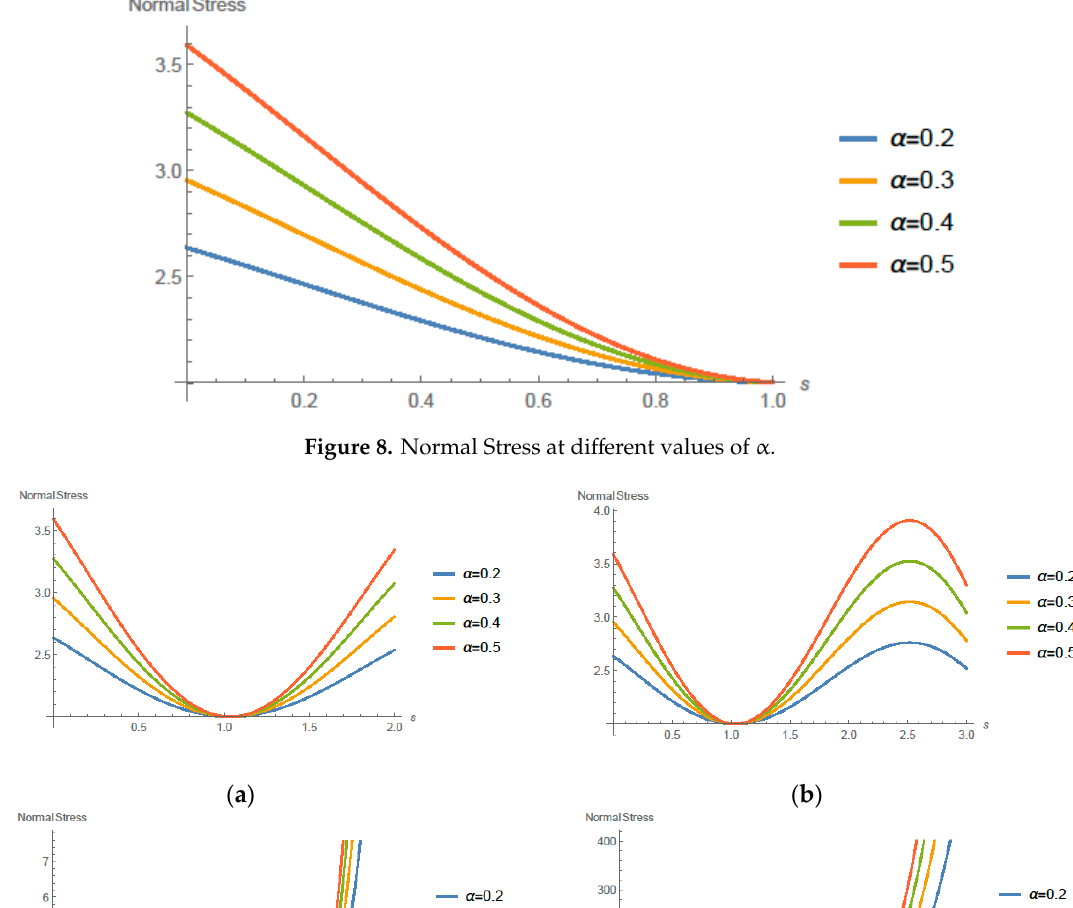
Figure 8. Normal Stress at different values of α .